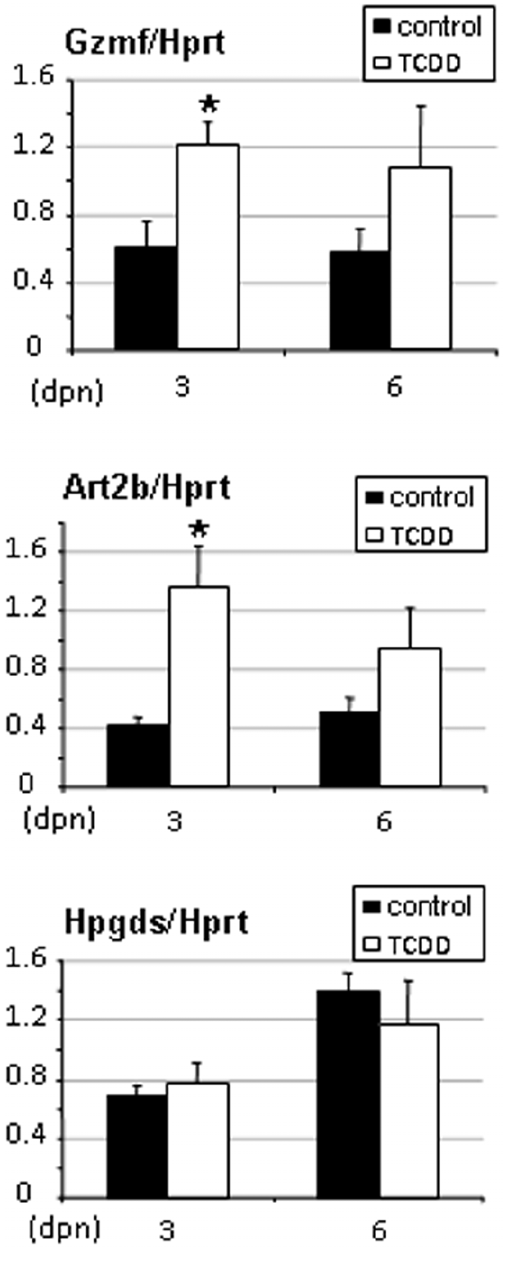
Figure 7. Gzmf, Art2b, and Hpgds gene expression levels in livers of rats exposed in utero to TCDD. Livers were recovered from females of 3 and 6 days of age. Levels were normalized using Hprt. Values are the mean 6 SEM of n =3 to 5 animals. *p , 0.05 versus its time-matched control. (dpn), days postnatal.